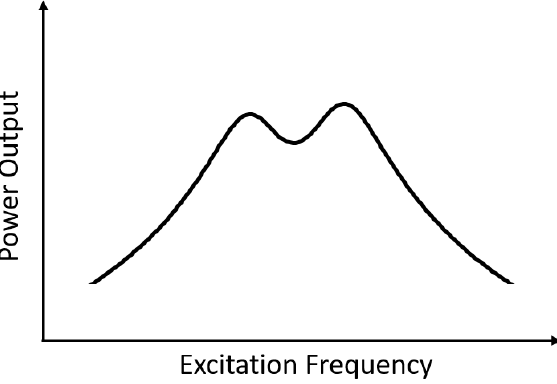
Figure 2. An ideal case for a frequency range of efficient operation, formed by two overlapping resonant modes (log